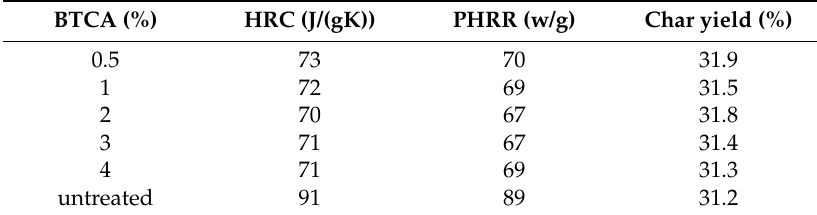
Table 1. The heat release properties and char yield of the Nomex ® /cotton blend fabric treated with BTCA at different concentrations, cured at 170 ◦ C for 3 min and finally subjected to one home laundering cycle. BTCA (%) HRC (J/(gK)) PHRR (w/g) Char yield (%) 0.5 73 70 31.9